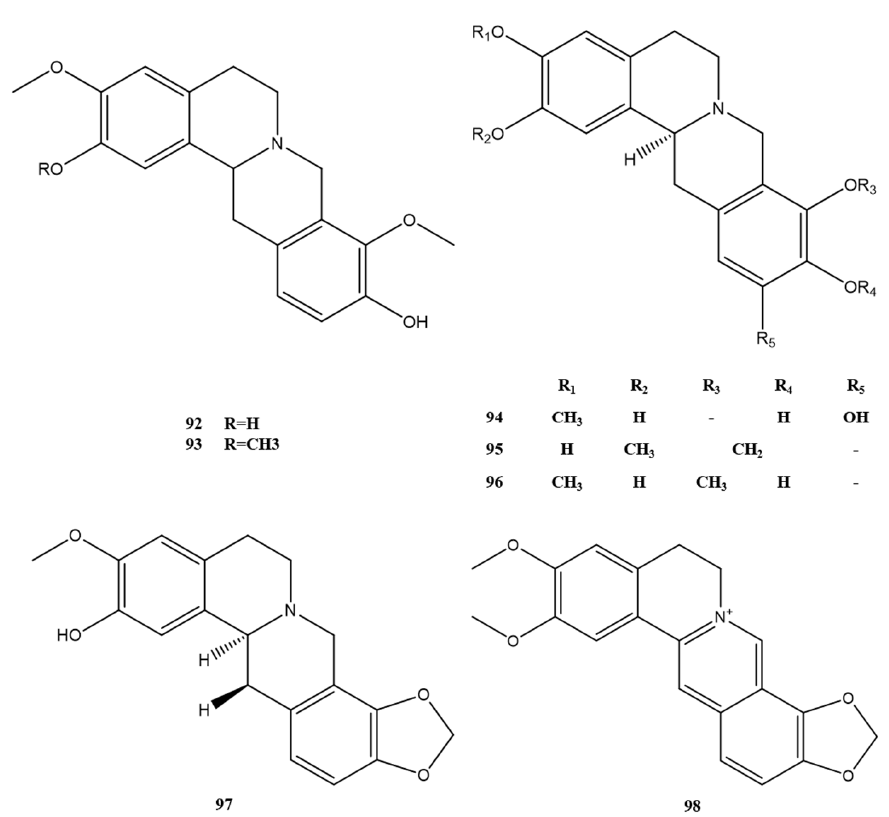
Figure 8. Protopberberine and berberine alkaloids in M. Rhizoma.